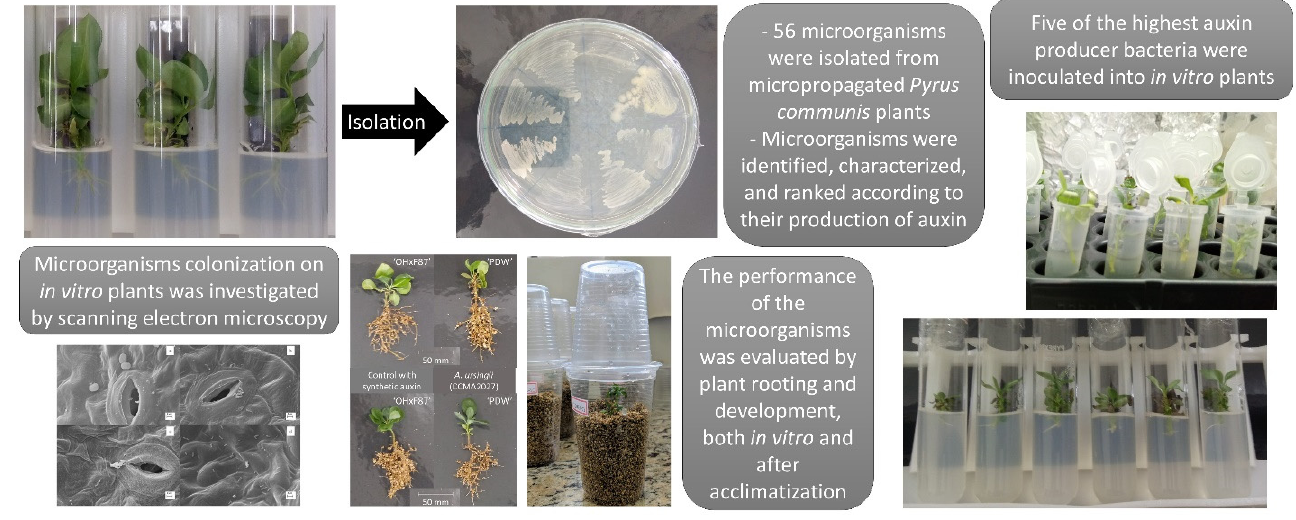
Figure 1. Experiment workflow.